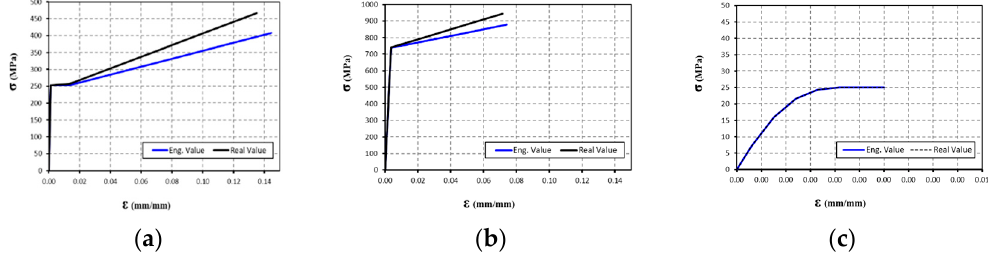
Figure 3. Constitutive models considered for ( a ) ASTM-A36 steel, ( b ) ASTM-A193 steel and ( c ) concrete.